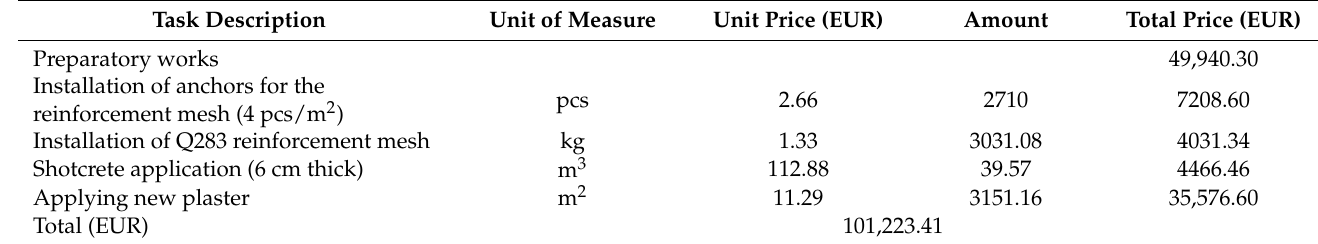
Table 12. Calculation of renovation costs—shotcrete.